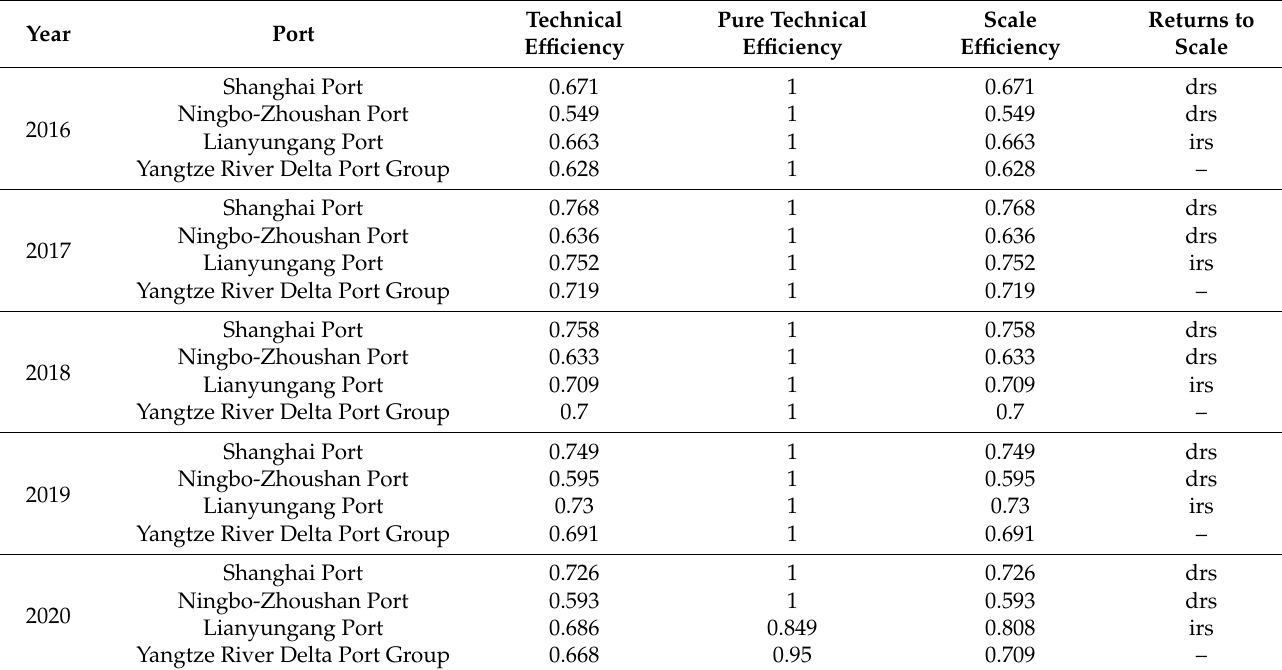
Table 3. The efficiency value of the coastal port group in the Yangtze River Delta from 2016 to 2020 in the first stage.